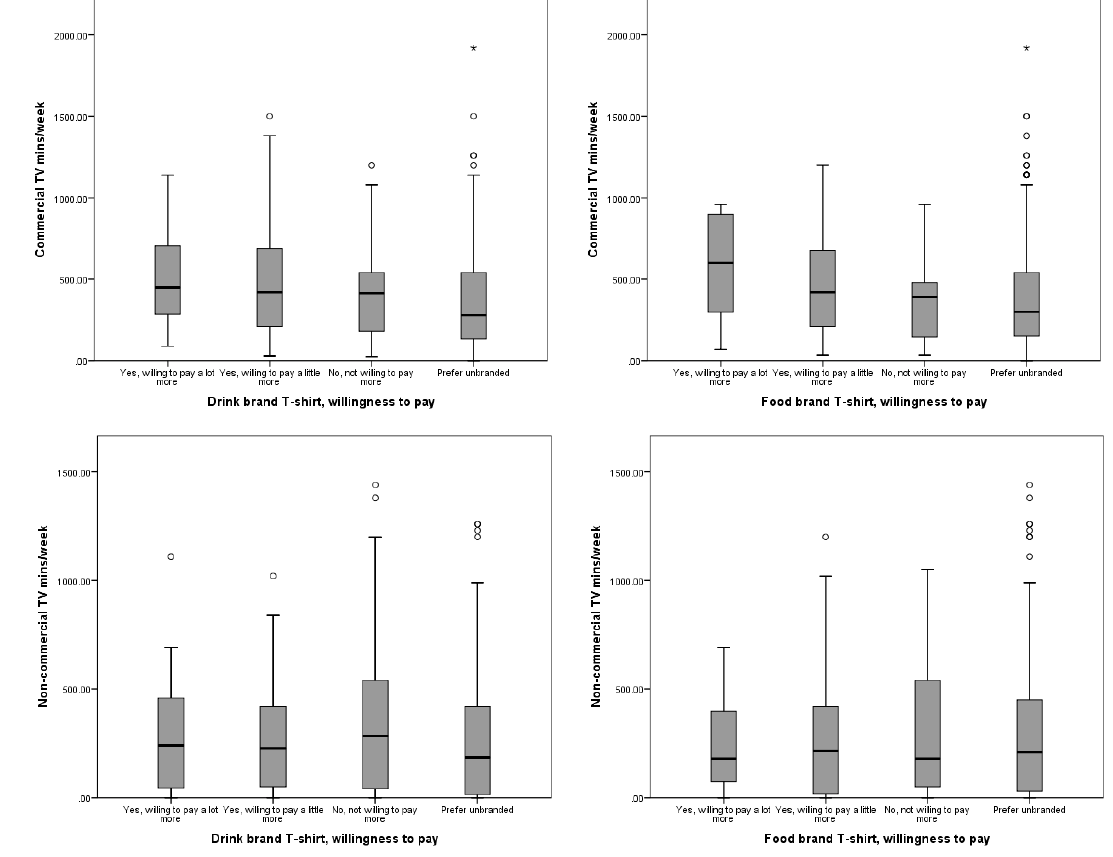
Figure 1. Distribution of commercial and non-commercial television viewing (mins/week) by Figure1. Distributionofcommercialandnon-commercialtelevisionviewing(mins / week)bywillingness willingness to pay for food- and drink-branded T-shirts. to pay for food- and drink-branded